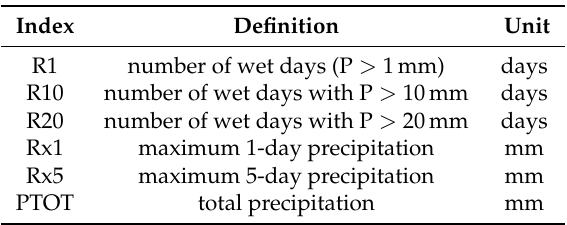
Table 3. Selection of climdex indices used in this study for intercomparison between different precipitation (P)